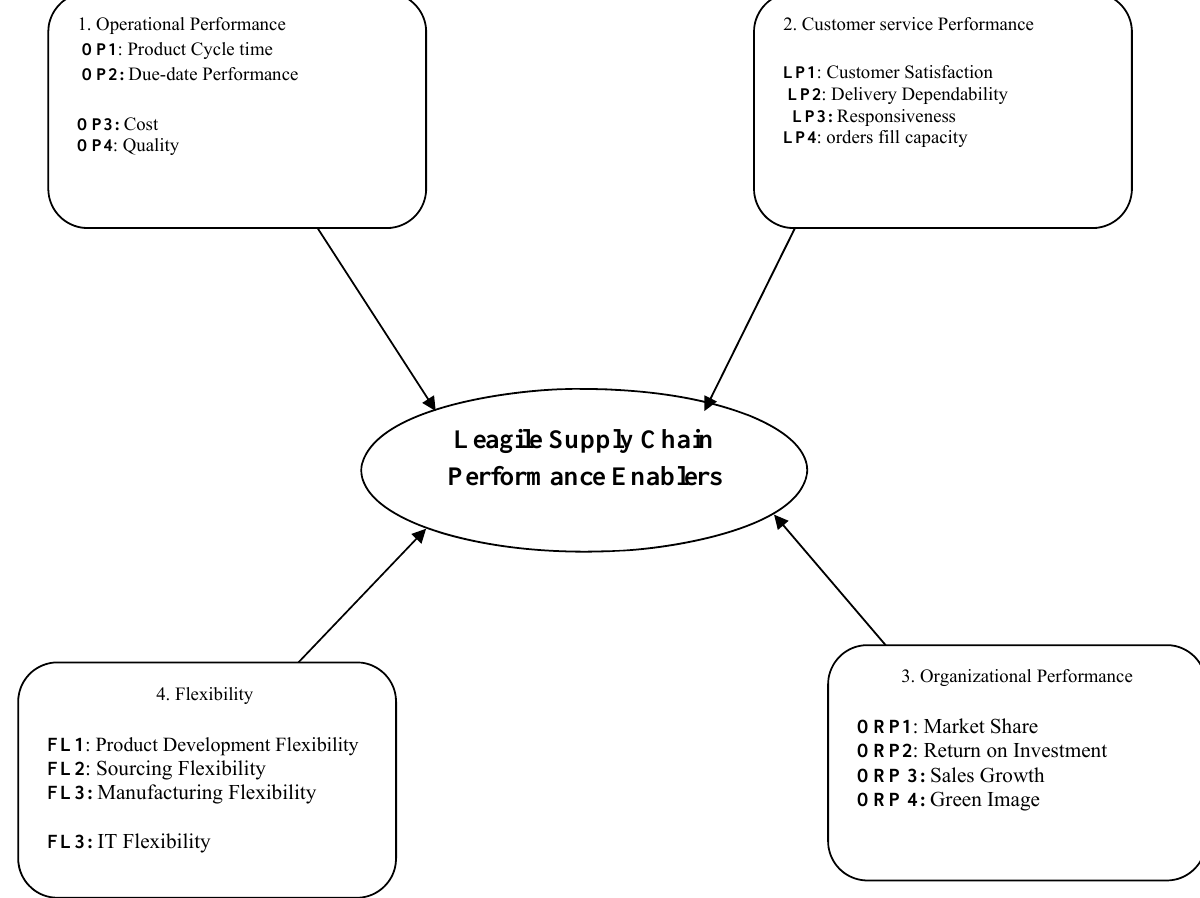
Fig. 1. The Conceptual Frame work of Leagile Supply Chain Performance